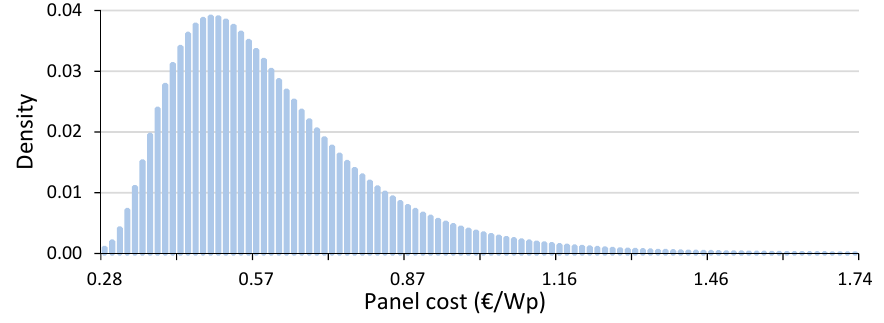
Figure 11. PDF of panel cost for a 50 kW system.